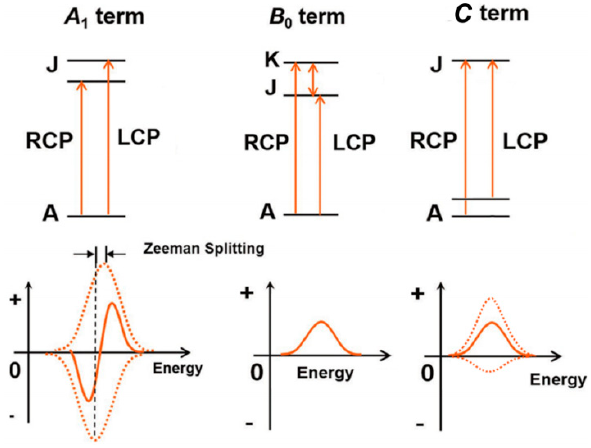
Figure 2. Scheme of band formation in magnetic circular dichroism spectra .